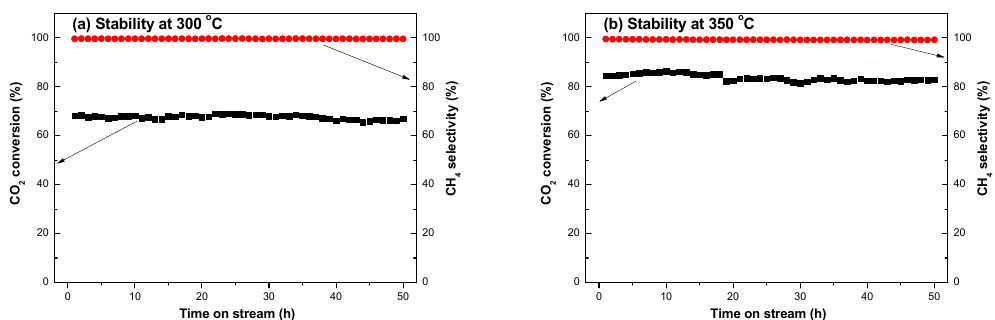
Figure 7. Stability of the 50%Ni-CeO 2 -CSC in CO 2 methanation: ( a ) stability at 300 °C, ( b ) stability at 350 °C.